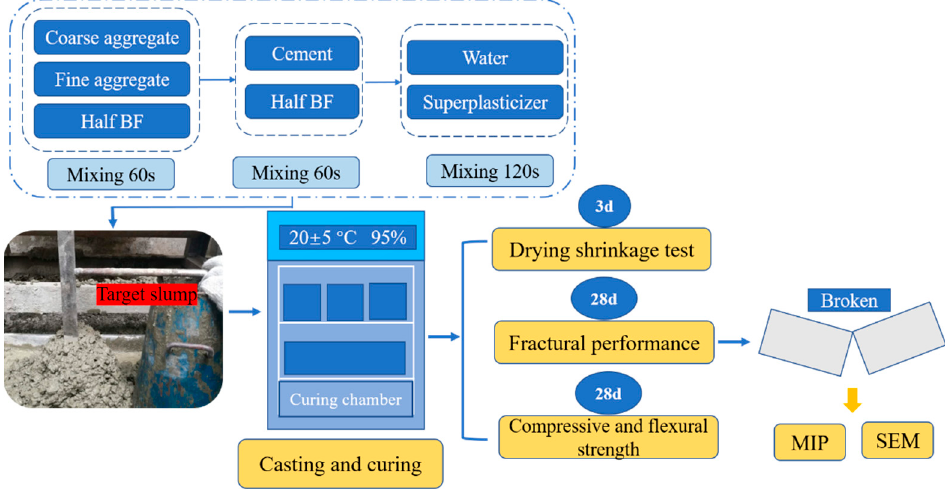
Figure 2. The diagram of test program.